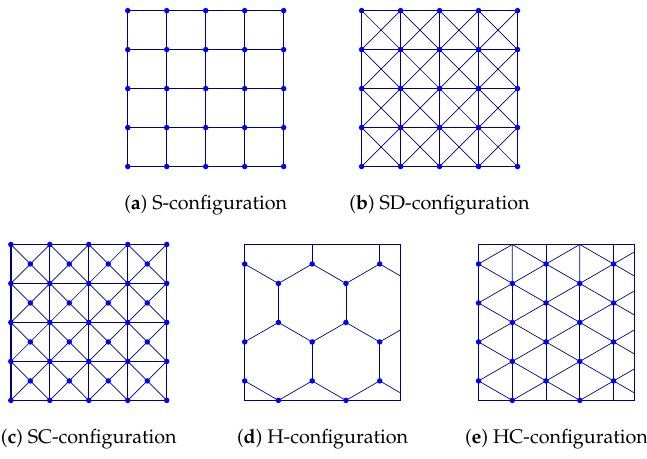
Figure 1. Regular geometrical grid configurations from [17].